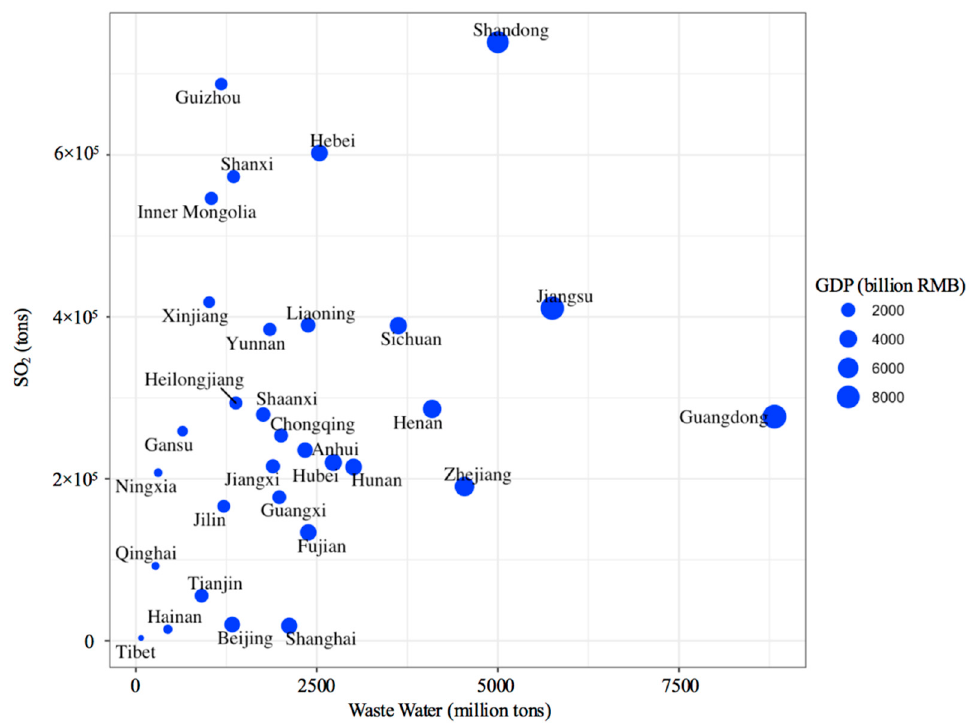
Figure 6. GDP and major pollutants of 31 Chinese provinces in 2017. The provincial-level data are extracted from the China Statistical Yearbook. Hong Kong, Macau and Taiwan are excluded due to lack of data.